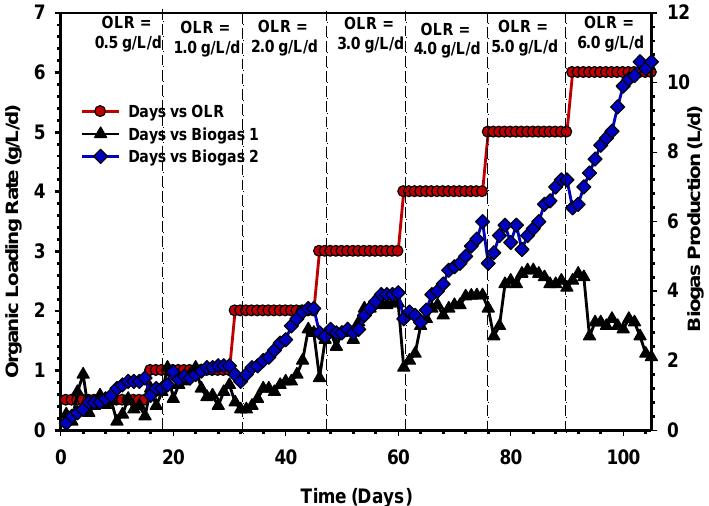
Figure 5. Daily biogas production over a period of operation of UASB 1 and 2.